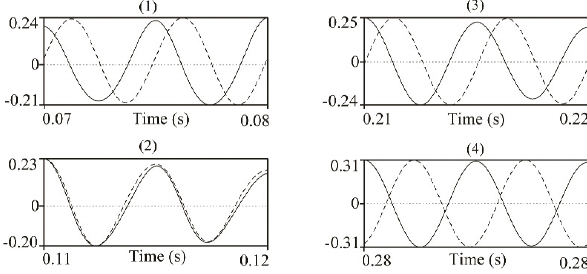
Figure 5: The effect of the throat signal phase shift (dashed line) relative to the filtered acoustic signal (solid line). The fragments (1)- (4) of the given figure correspond to the segments 1-4 in Fig.